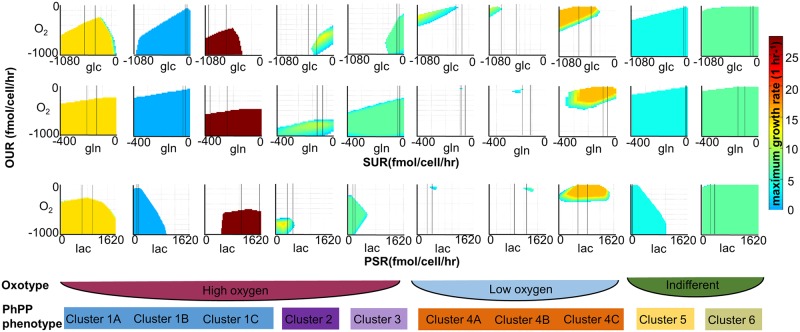
Six model clusters are distinguished according to the models’ robustness towards environmental changes.Heatmaps display results for one model from each cluster (and subcluster). Lines in the heatmaps indicate the constraints imposed on the exemplified model. Lac = lactose, glc = glucose and gln = glutamine.